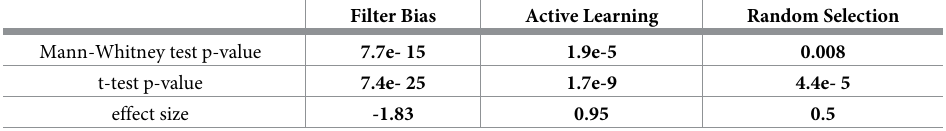
Table 17. Results of the Mann-Whitney U test and the t-test comparing the inequality of prediction for the three forms of iterated algorithmic bias with the Movielens data set. The negative effect size indicates that filter bias leads to high inequality of relevance prediction. Both random selection and active learning significant decrease on the